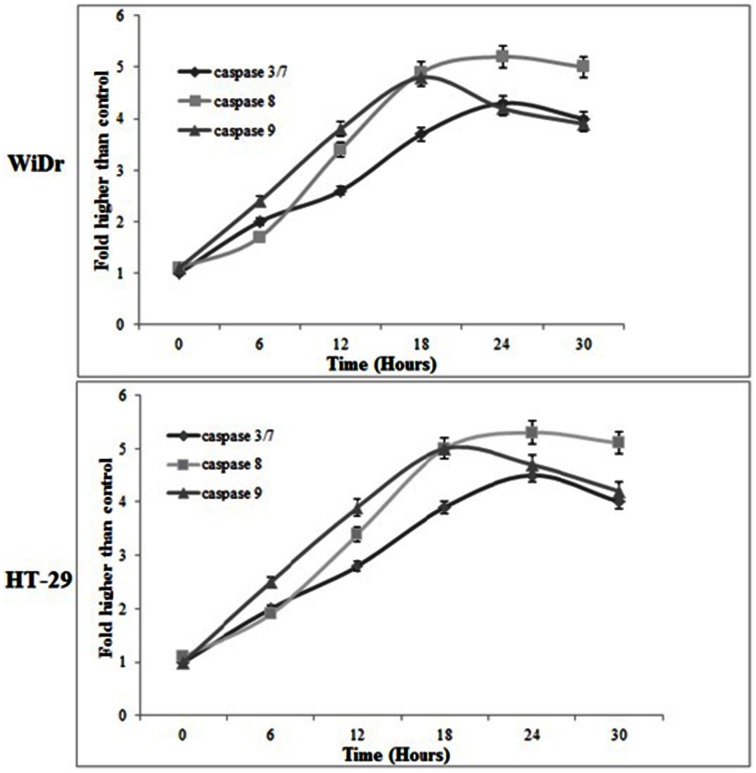
Time-dependent activation of caspase 3/7, 8 and 9 by NTC (6.0 μM). The results disclosed a significant activation in caspase 3/7, 8, and 9 in a time-dependent manner. All data were expressed as the means ± standard error of triplicate measurements.